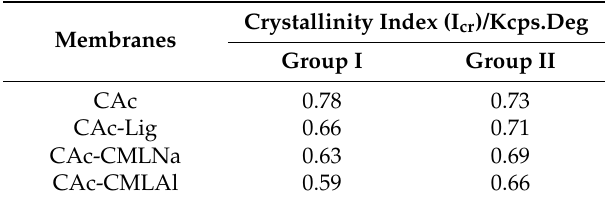
Table 4. Crystallinity index measured by X-ray diffraction